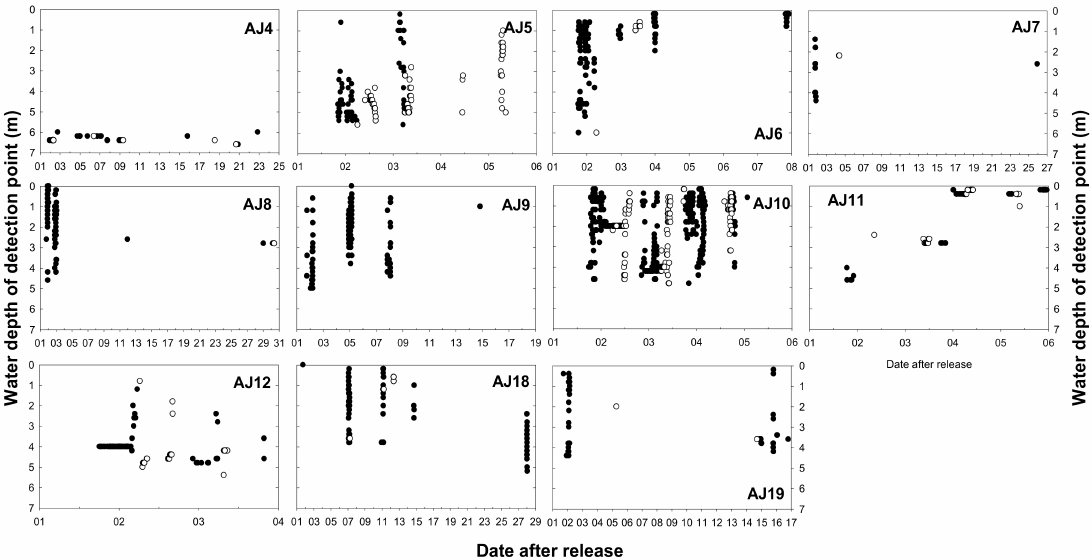
Figure 6. Daily movement patterns of 11 A. japonica fitted with a depth sensor: black and white circles indicate nighttime and daytime detection, respectively. AJ15 was excluded because there was no vertical